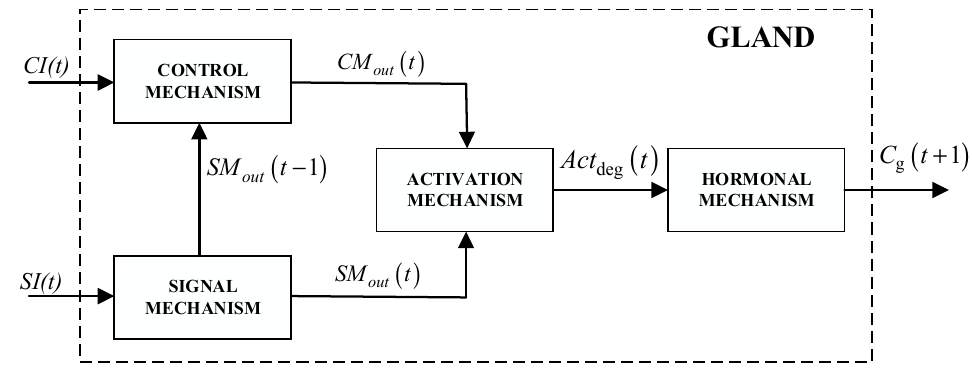
Figure 1. AOG mechanism.